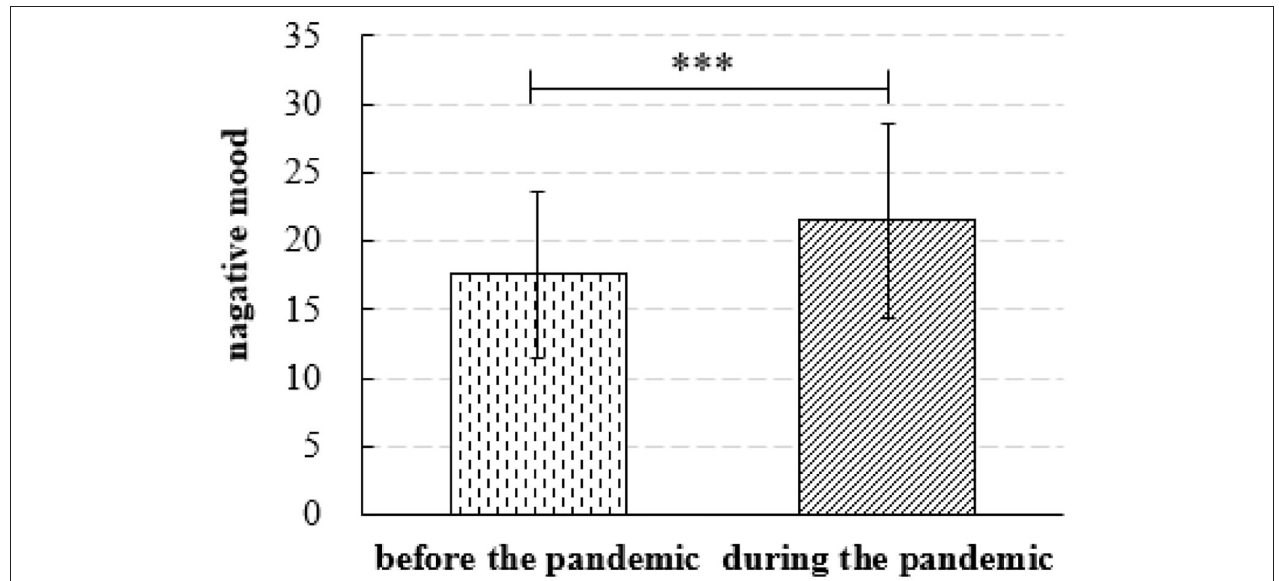
FIGURE 3 | Mean scores of participants’ negative mood measured by the PANAS-negative. Error bars represent standard deviation ( SD ). *** p < 0.001. bootstrapping sample size of 5,000 and a 95% confidence